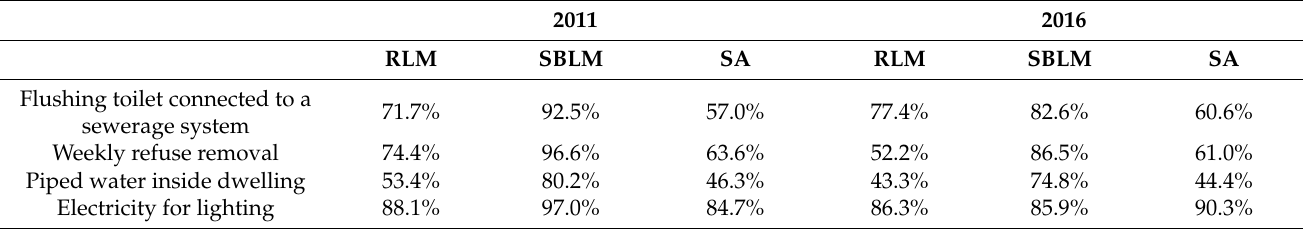
Table 5. Infrastructure in RLM and SBLM.